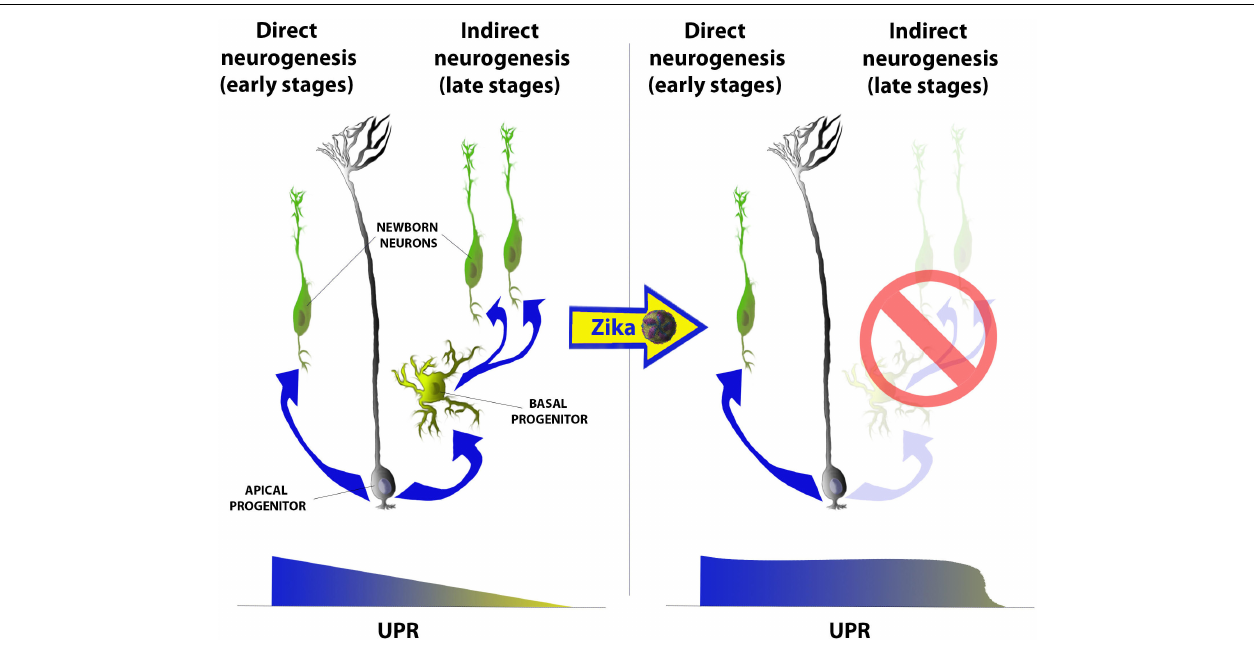
FIGURE 2 | Schematic representation of the gradual shift from direct (left) to indirect (right) neurogenesis and of its imbalance after Zika infection in mammalian cerebral cortices. Briefly, at early stages of corticogenesis (from E10.5 to E13.5 in mice) apical progenitors (AP) populating the ventricular zone (VZ) of the rostral neural tube start producing first neurons, which will give rise to the primordial cortical plate (CP). At these stages the level of UPR is higher then later stages and gradually decreases as development proceeds. From E13.5 onward (in mice) AP start producing at least other two progenitor populations: basal progenitors and outer radial glia (not in the scheme) and, as UPR decreases, this neurogenic mode (called indirect) becomes gradually predominant. Indirect neurogenesis is only present in mammals (among all vertebrates) and mainly contributes to the amplification of the neuronal output during corticogenesis. Upon Zika infection, instead, UPR levels remain high also at later stages of development and the predominant mode of neurogenesis remains the direct one leading to a decrease in the total neuronal output and, hence, to a microcephalic